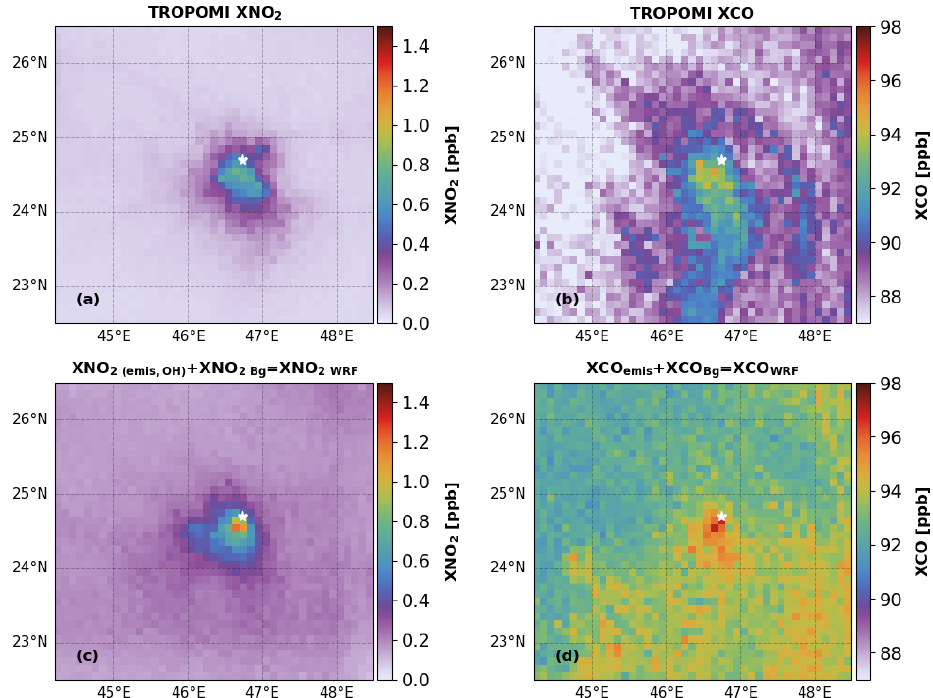
Figure 2. Comparison between XNO 2 (a, c) and XCO (b, d) from TROPOMI and WRF over Riyadh, averaged over June to October 2018. Panels (a) and (b) show TROPOMI data, and panels (c) and (d) show the corresponding co-located WRF results. XNO 2 WRF is derived by adding XNO 2(emis, OH) and XNO 2 Bg . XCO WRF is derived by adding XCO emis and XCO Bg . The white star represents the center of the city. TROPOMI and WRF results are gridded at 0 . 1 ◦ × 0 . 1 ◦